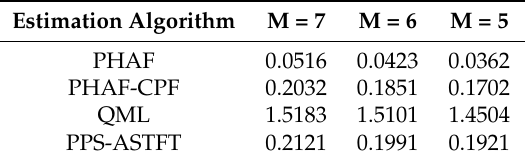
Table 2. Simulation